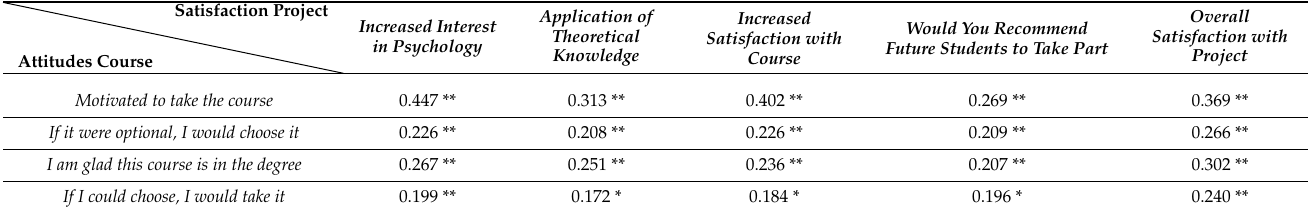
Table 5. Correlations between satisfaction and attitude